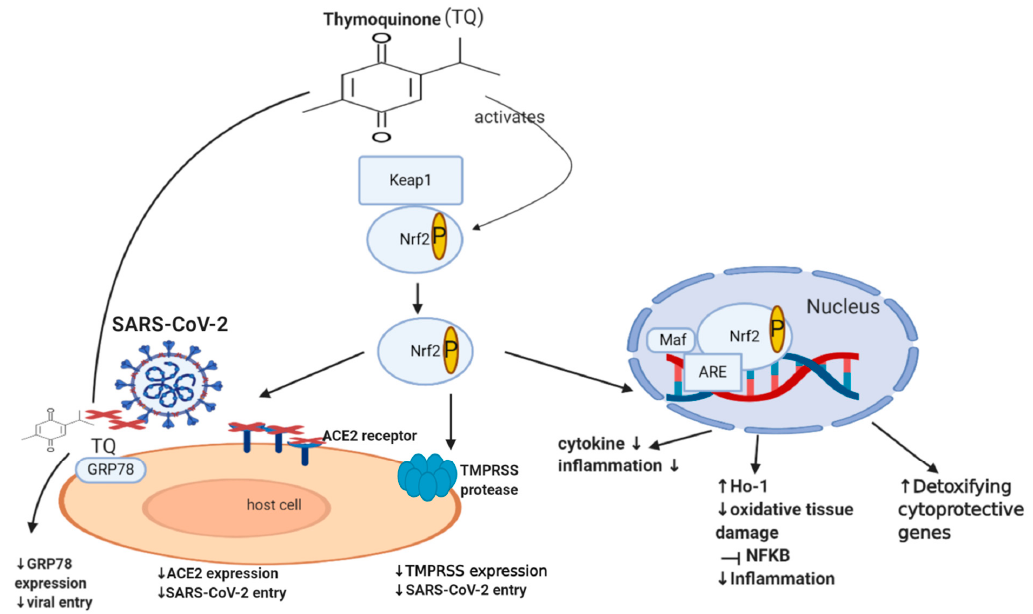
Figure 2. Effect of TQ on Nrf2, GRP78 and SARS-CoV-2 infection . A diagram showing the effect of TQ on Nrf2; it activates Nrf2 by phosphorylation, causing its translocation inside the nucleus, binding to ARE (antioxidant response element) and Maf. This binding results in the reduction of NF-kB, cytokine production, inflammation, oxidative damage and an increase in detoxifying cytoprotective genes and enzymes such as the HO-1 enzyme. Moreover, TQ decreases GRP78 expression, angiotensin-converting enzyme 2 (ACE)-receptor expression and hence decreases viral entry.